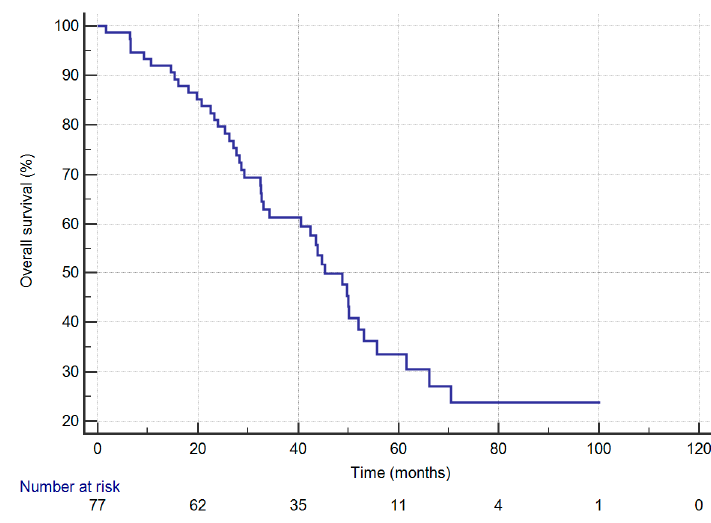
Figure 1. Overall-survival curves of 77 patients with completely resected stage IIIA-N2 non-small-cell lung cancer.